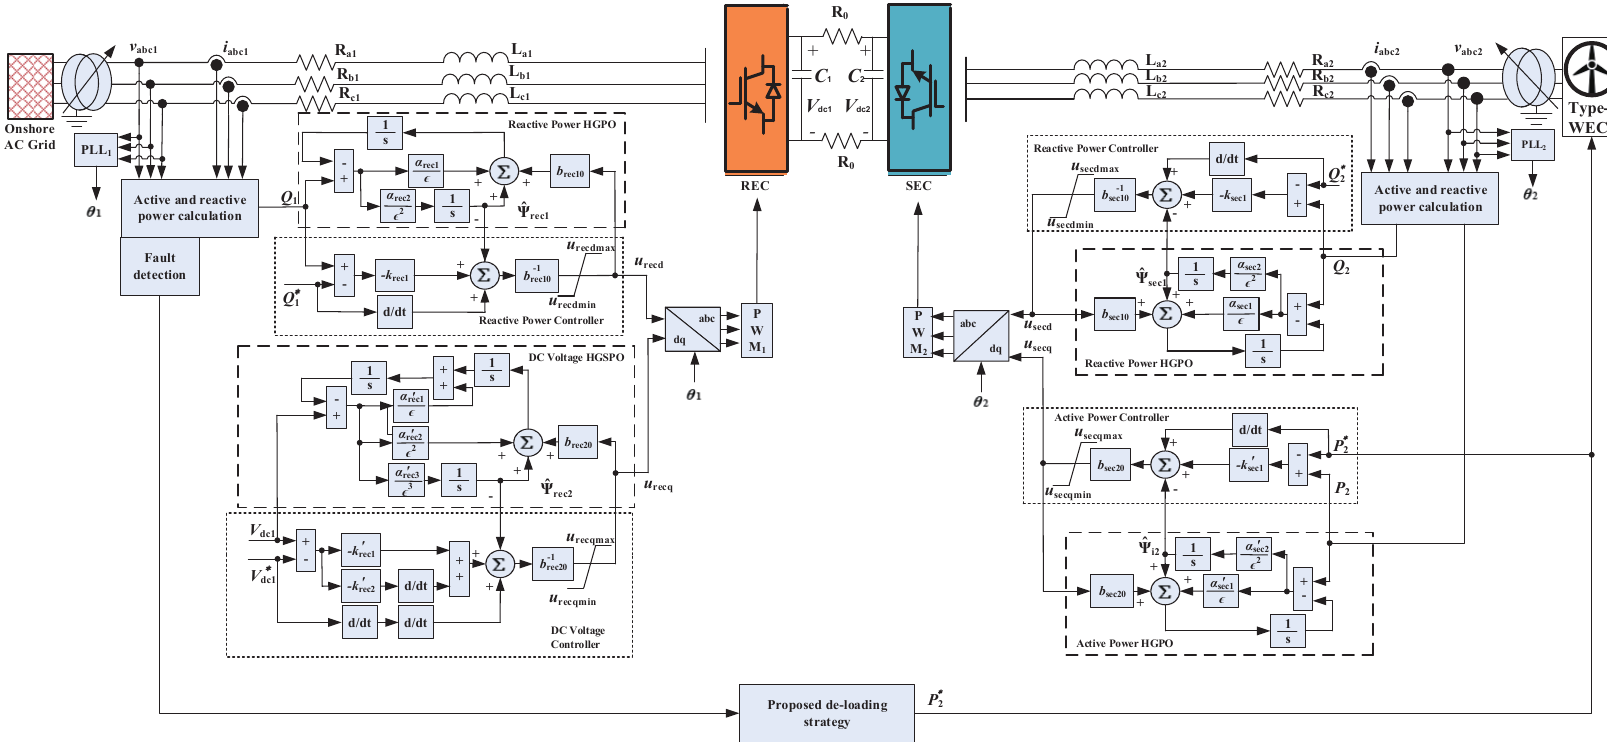
Figure 4. The overall control structure of the nonlinear adaptive control (NAC)-based receiving end VSC station (REC) controller and sending end VSC station (SEC) controller of the VSC-HVDC systems with type-4 wind energy conversion systems